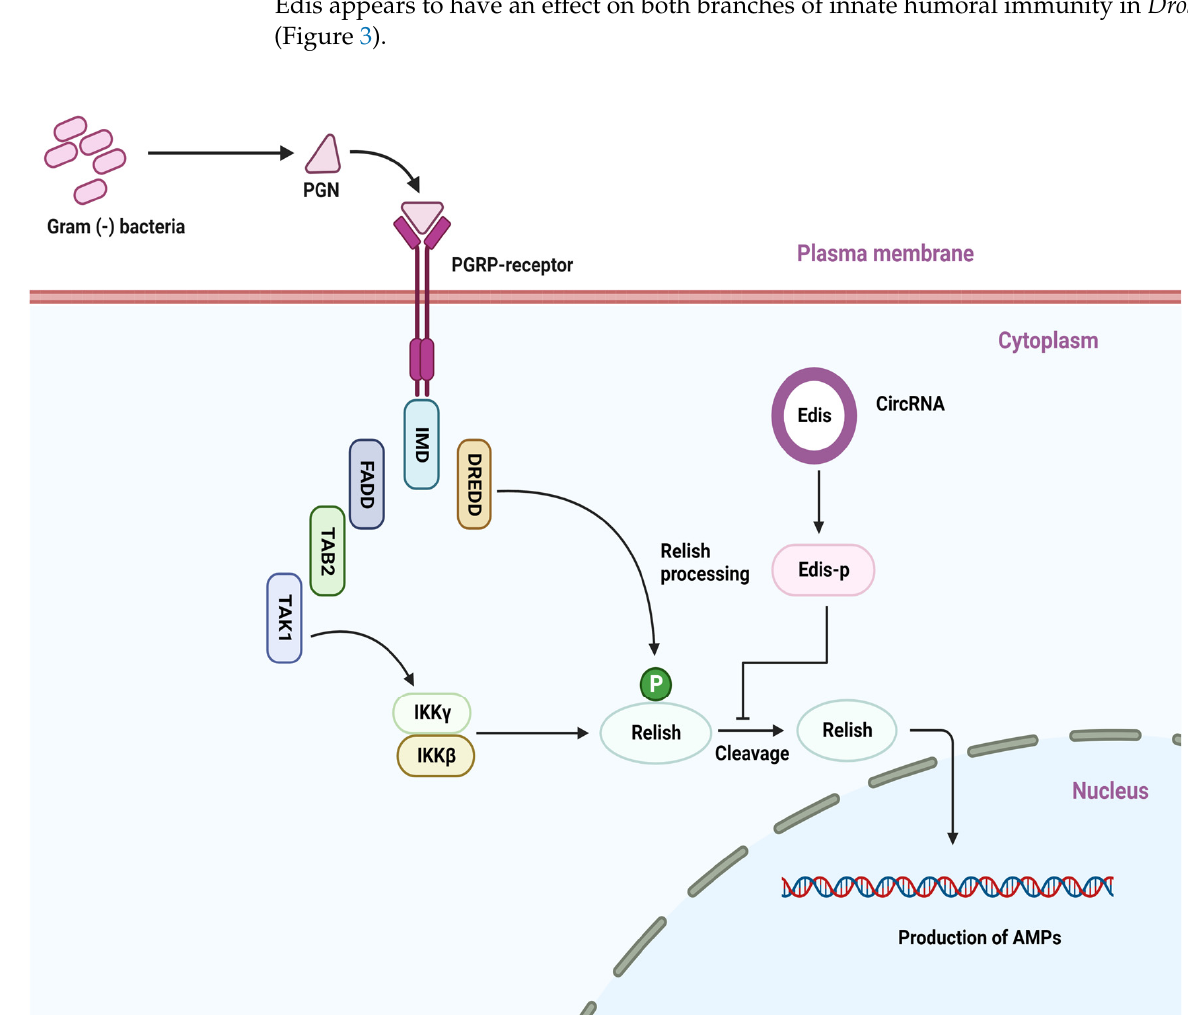
Figure 3. Representative circular RNAs play a biological role in the modulation of the IMD signaling pathway. The PGRP receptor recognizes various bacterial components and induces a downstream signaling cascade.